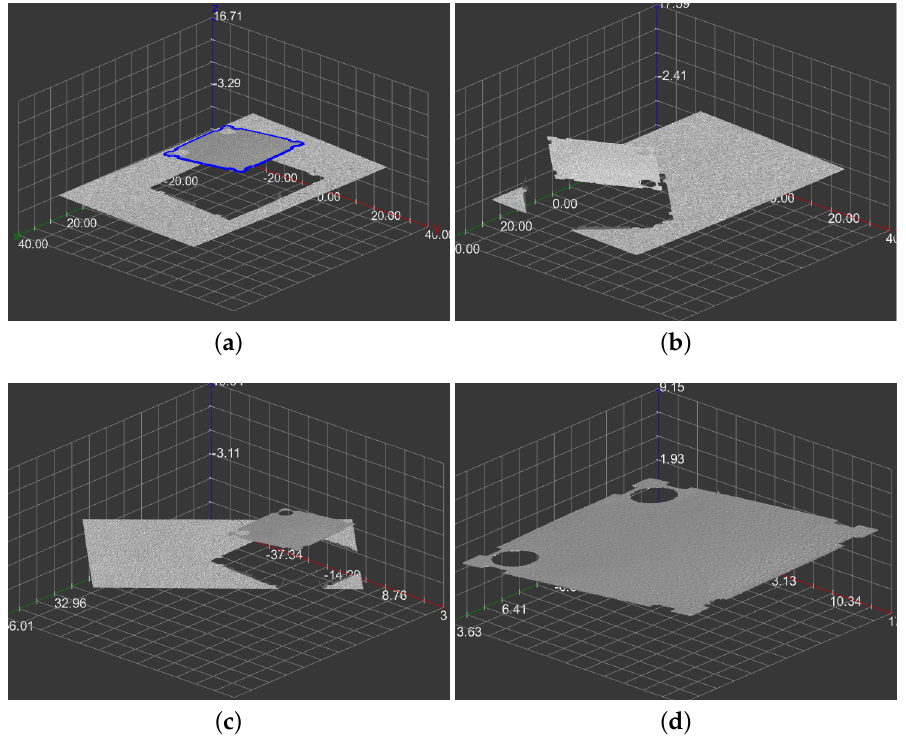
Figure 8. Results for a single input. ( a ) Contour selected for the template; ( b ) the input depth map; ( c ) the aligned depth map; ( d ) the recognized and aligned object.